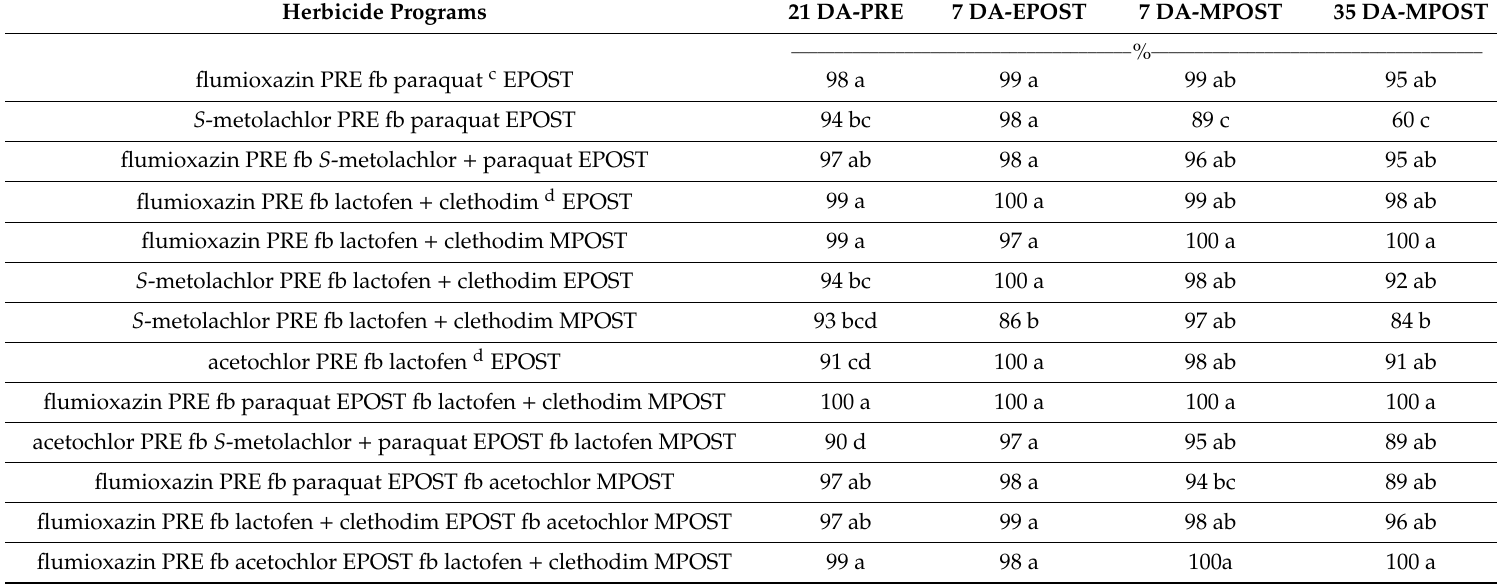
Table 4. Control of hemp sesbania 21 DA-PRE, 7 DA-EPOST b , and 7 and 35 DA-MPOST b treatments in Weed Control Study at Stoneville, MS, averaged over 2017 and 2018 a